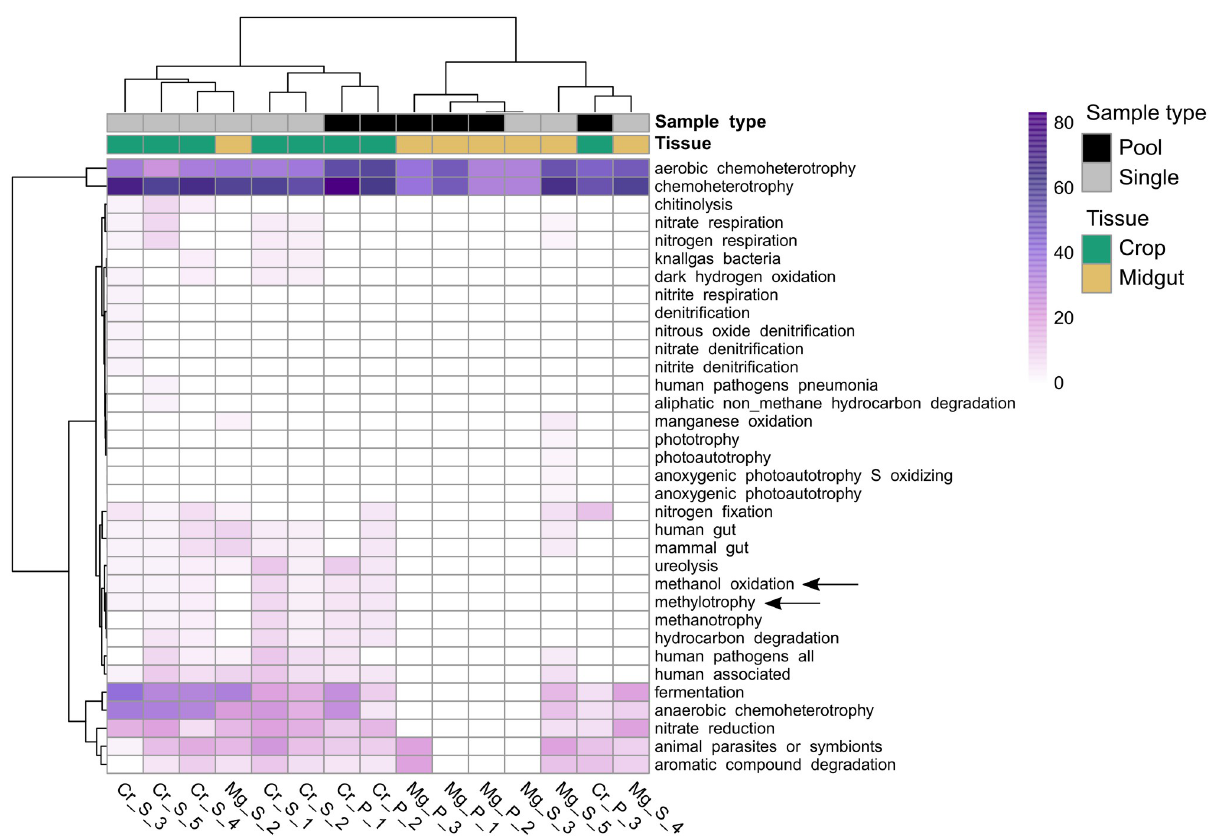
Fig 8. Predicted community metabolic profiles reveal a predominant clustering pattern driven by tissue. The heatmap represents the relative abundance of the predicted pathways (rows) in the community from each sample (columns) based on the FAPROTAX database. The color key highlights the tissue of origin (teal/beige) and sample type (black/gray) of each bacterial community. Statistical significance indicated by an arrow (p < 0.05) was tested by Wilcoxon rank sum test followed by an FDR correction.